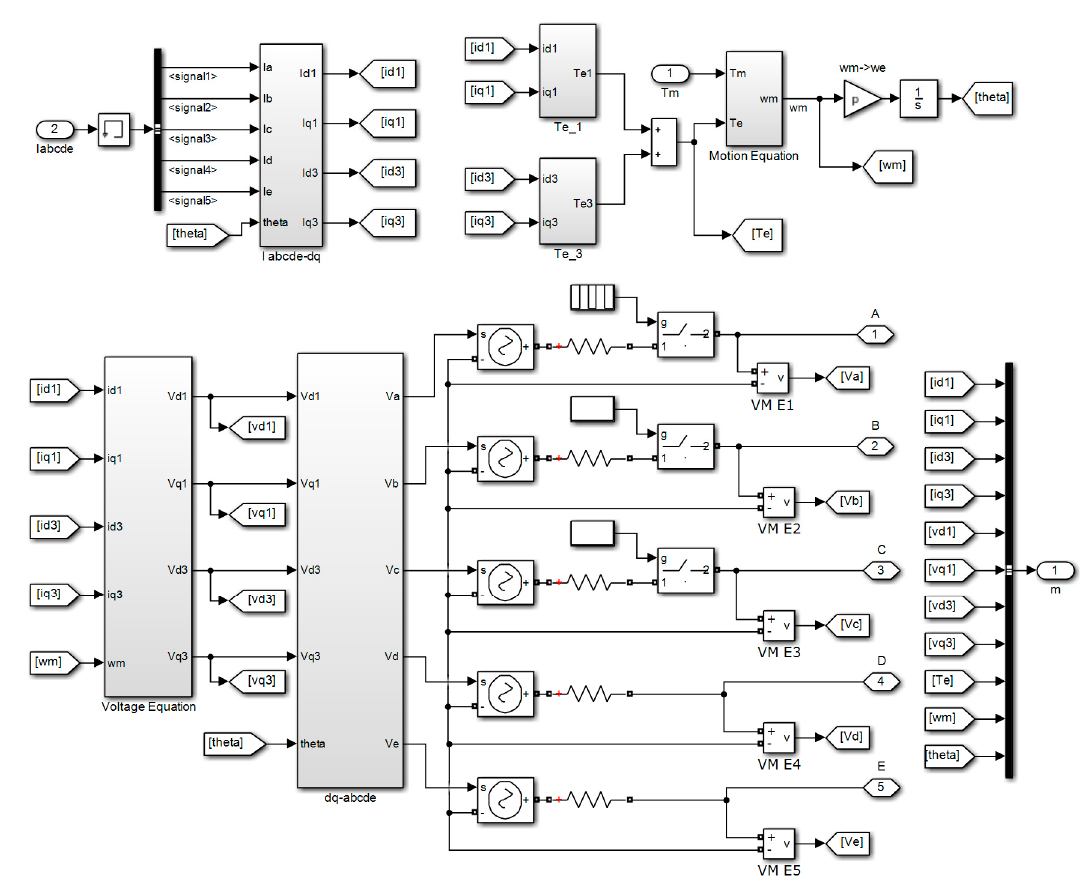
Figure 3. Simulation blocks of the FP-PMSG with third harmonic windings (THWs).